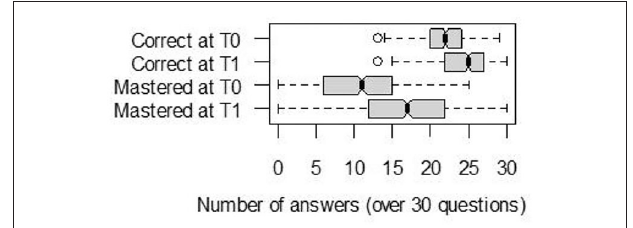
FIGURE 2 | Median, lower and upper quartiles, of correct and mastered answers, over the 30 questions about complementary feeding answered by n = 452 parents at T0 and T1.